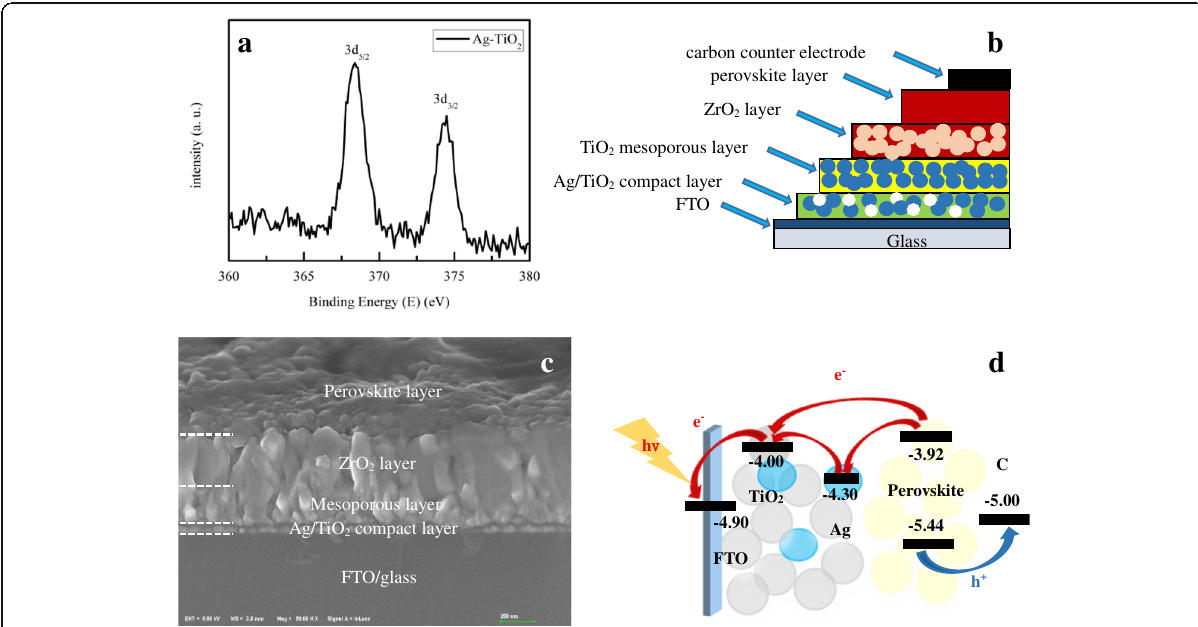
Fig. 2 a Ag 3d XPS spectra of Ag/TiO 2 composites. b Device structure of a Ag/TiO 2 perovskite solar cell. c A cross-sectional FE-SEM image of Ag/TiO 2 perovskite solar cell. d Schematic diagram of the photo generated carriers separation and transfer (the gray, blue, and yellow circles represent anatase TiO 2 , Ag, and perovskite